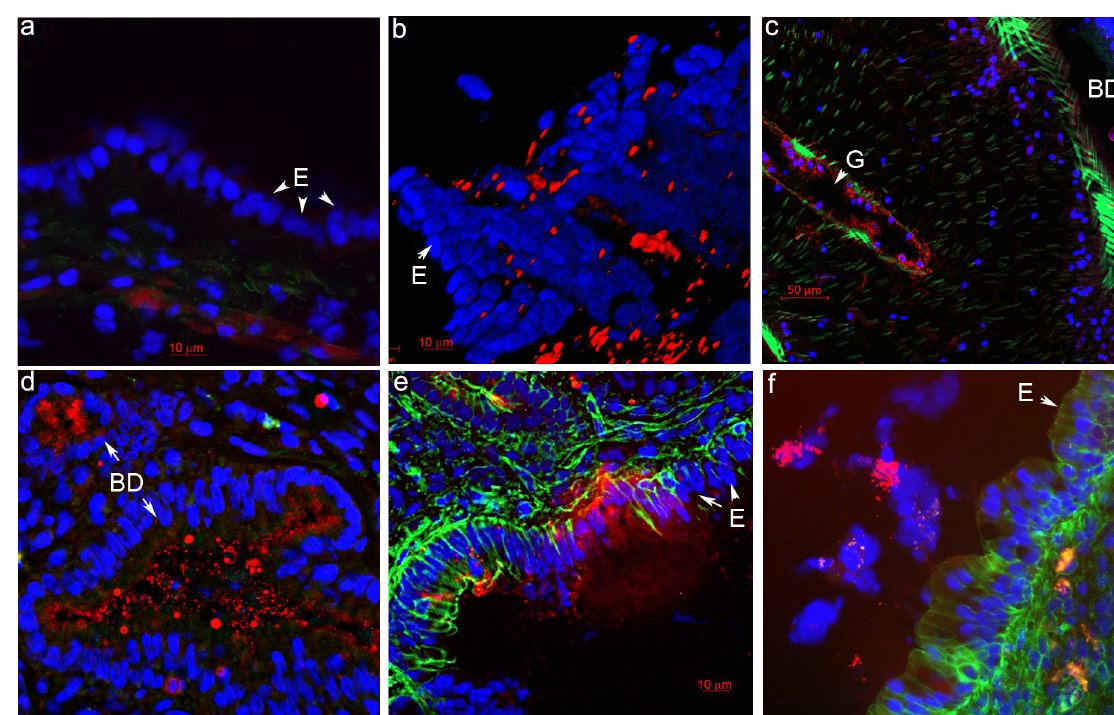
Fig 8. Enterobacteriaceae (Lipid A) in the liver of the uninfected and the liver fluke-infected hamsters. a. An uninfected hamster. b. 3D reconstruction of the internal surface of a bile duct after confocal microscopy reveals the presence of Enterobacteriaceae Lipid A. c. Bacteria inside the gut of the O . viverrini parasite. d. Enterobacteriaceae presence inside small bile ducts of an O . viverrini –infected hamster. e. Penetration of bacteria through the injured epithelium in the bile duct of an O . felineus –infected hamster. f. A multilayered epithelium in the bile duct of a C . sinensis –infected hamster. E: epithelial cells; BD: bile duct; red color: Lipid A of Enterobacteriaceae; green color: actin filaments (Phalloidin 488 staining); blue color: nuclei (DAPI staining). E: epithelium of bile duct; BD: bile duct; G: gut of a